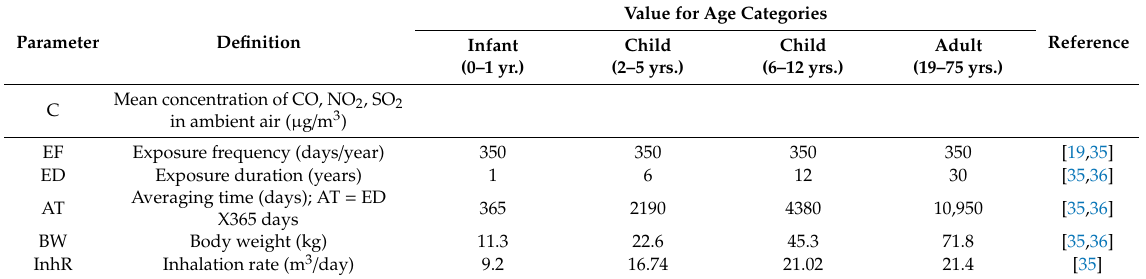
Table 2. Recommended values in equations of the daily exposure dose of CO, NO 2 , SO 2.